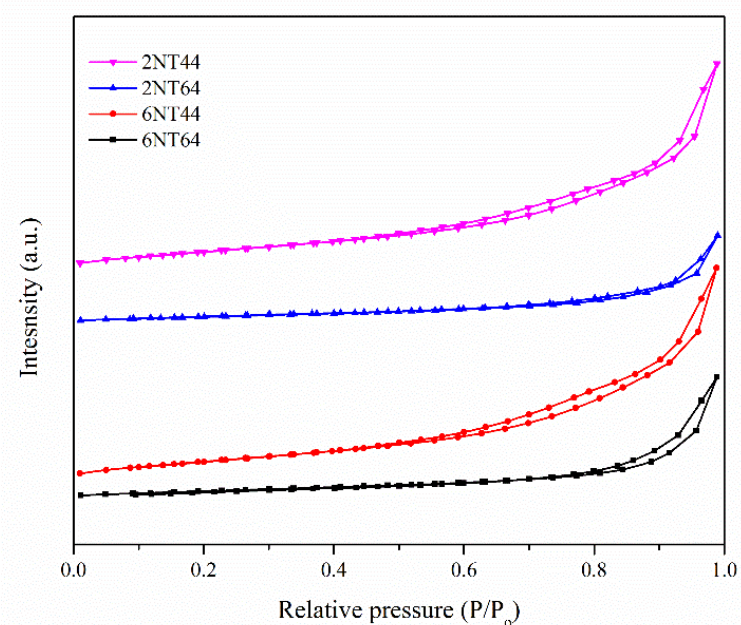
Fig. 3: XRD patterns for different N-doped TiO 2 sample